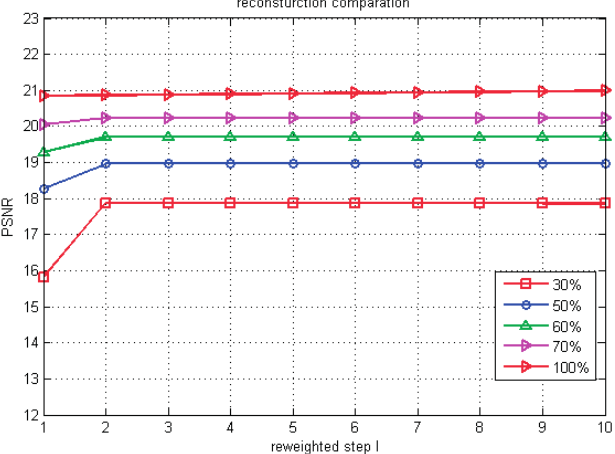
Figure 4. PSNR performances of the reconstruction image of RRIA with 10 reweight